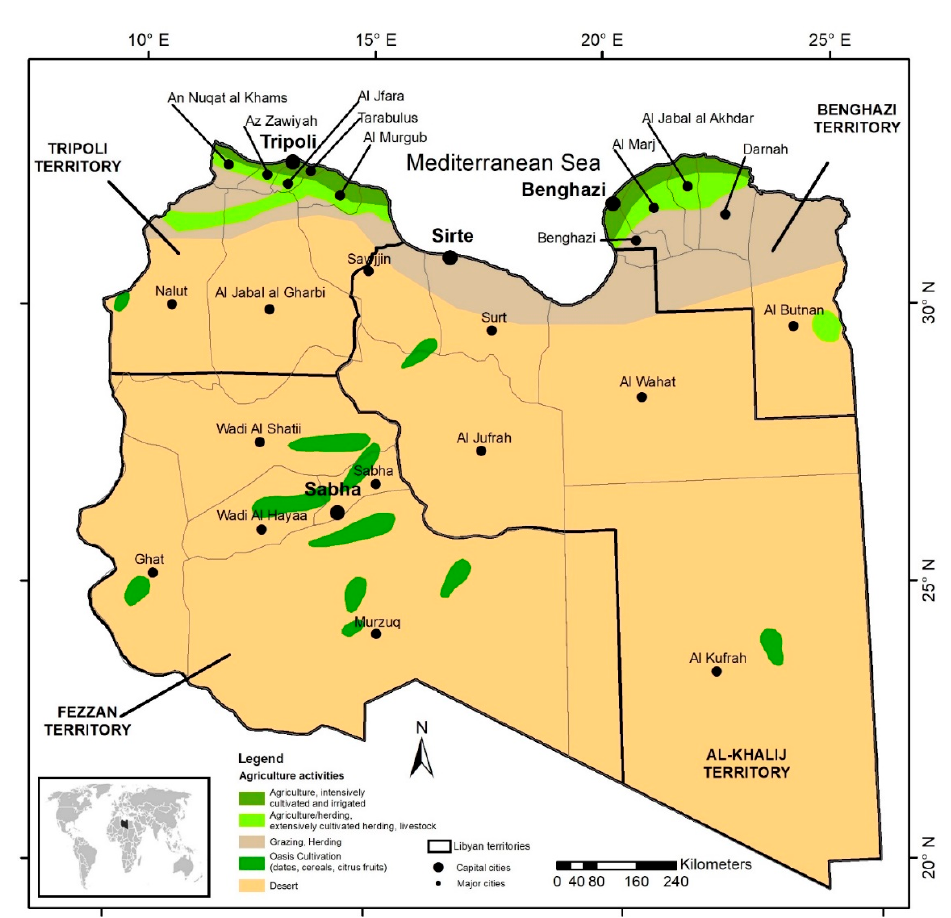
Figure 1. Locations of agricultural activities in Libya [14].